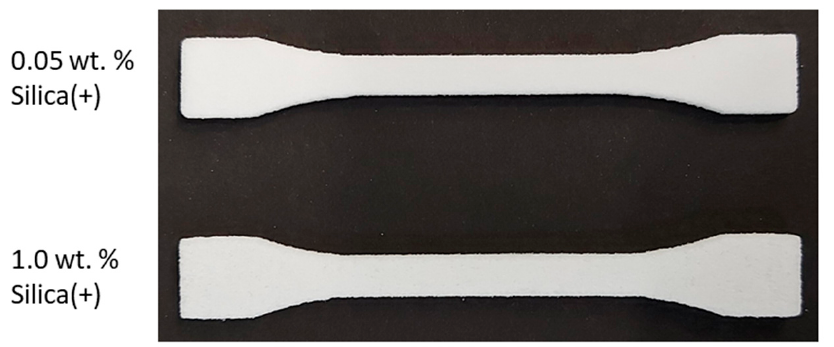
tographic powder deposition possible; 1.0 wt.% Silica(+), degree of coverage increased.